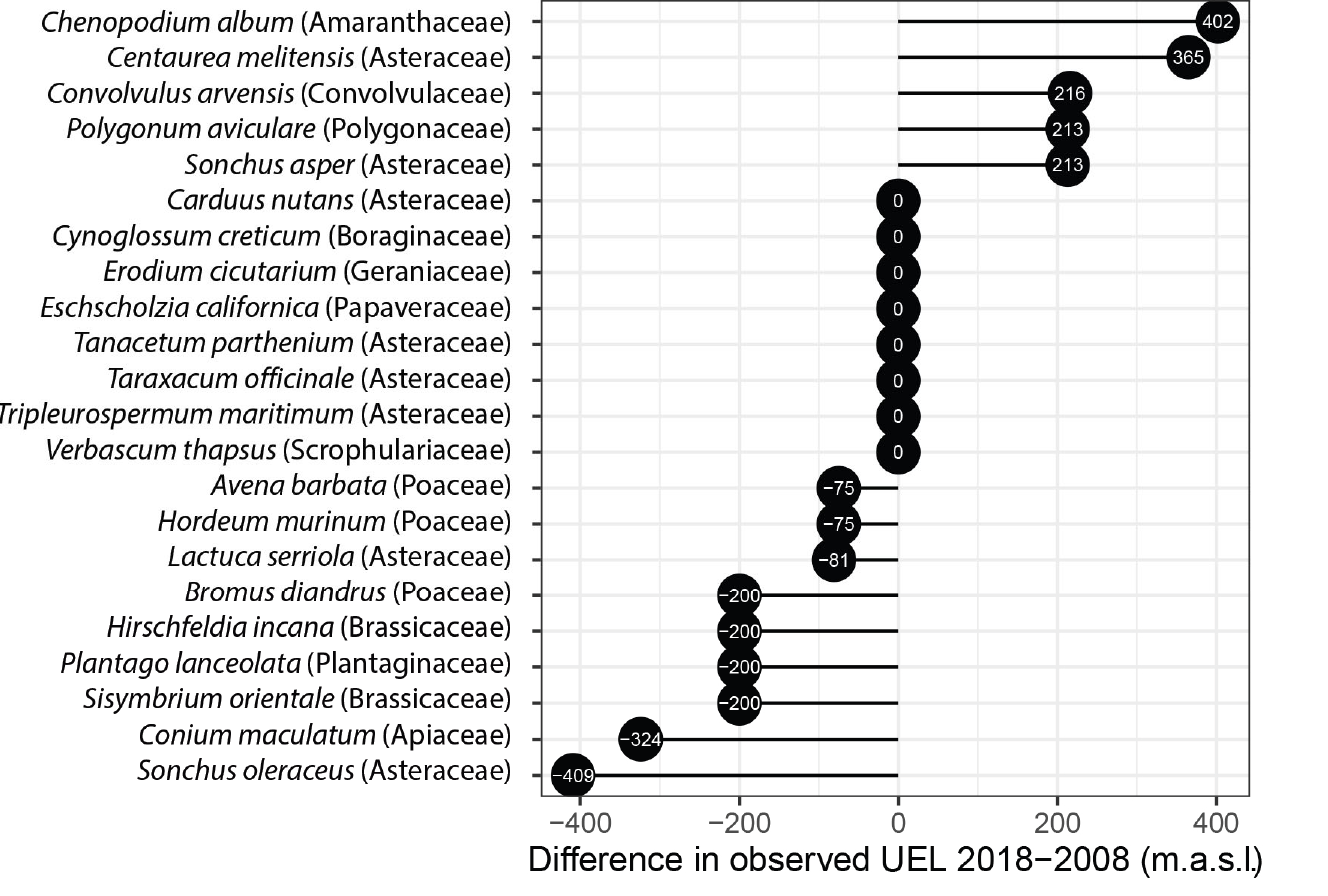
Figure 1. Temporal changes in the observed UEL (in meters) of 22 alien species recorded along an elevation gradient between 2008 and 2018 in the study area of central Chile (33°).